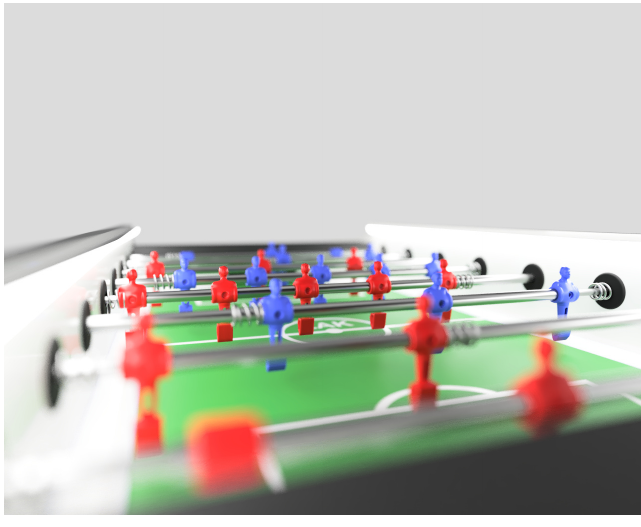
Figure 11. Table